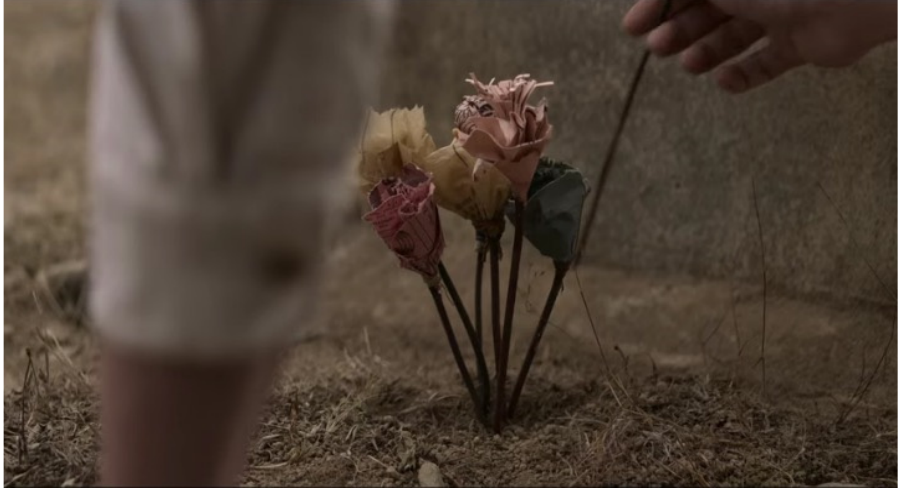
Figure 7. The Power of the Dog .